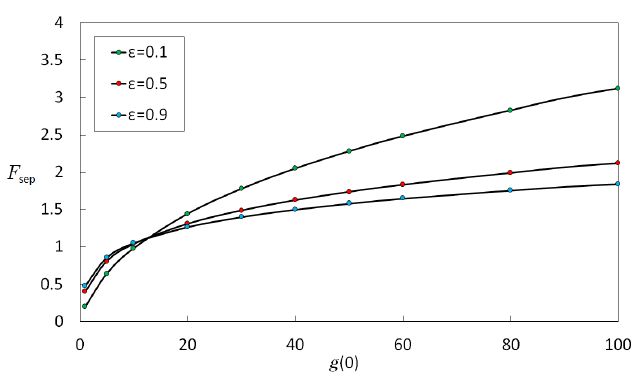
Figure 3. Dependence of the majorant F sep on the width w of the coupling constant g ( x ) for different values of the parameters ε and the amplitude of the coupling constant g ( 0 ) . ( Left ) ( Right ) ε = 0.5; D ( 0 ) = 1.